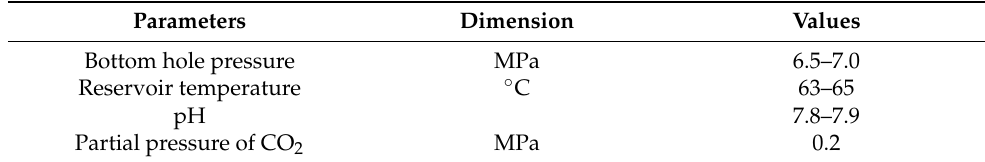
Table 2. Properties by reservoir.